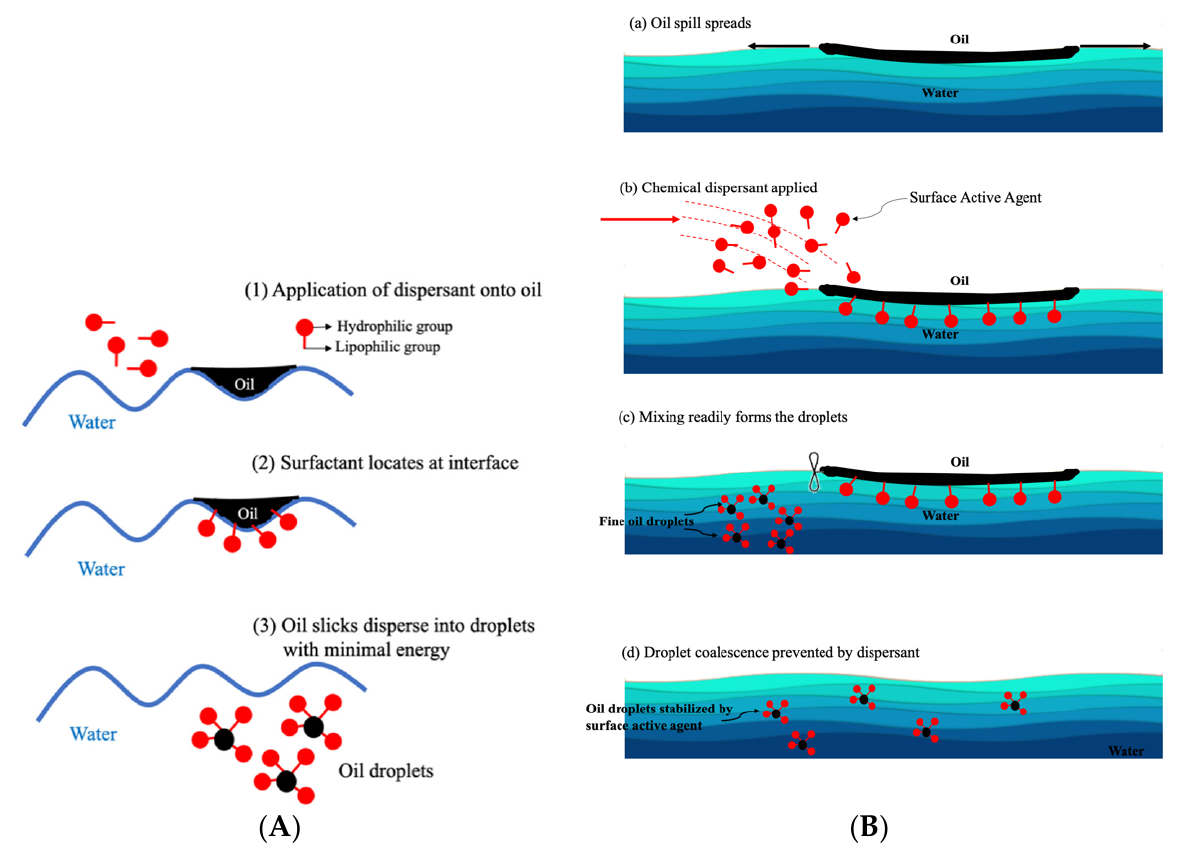
Figure 2. ( A ) How dispersants work: (1) oil and water do not mix. (2) Dispersants are applied to the surface of the oil film, and surfactant diffuses the oil/water interface where they align themselves. (3) The interfacial tension is reduced, and oil is dispersed as tiny droplets. ( B ) Mechanism of chemical dispersion [16].